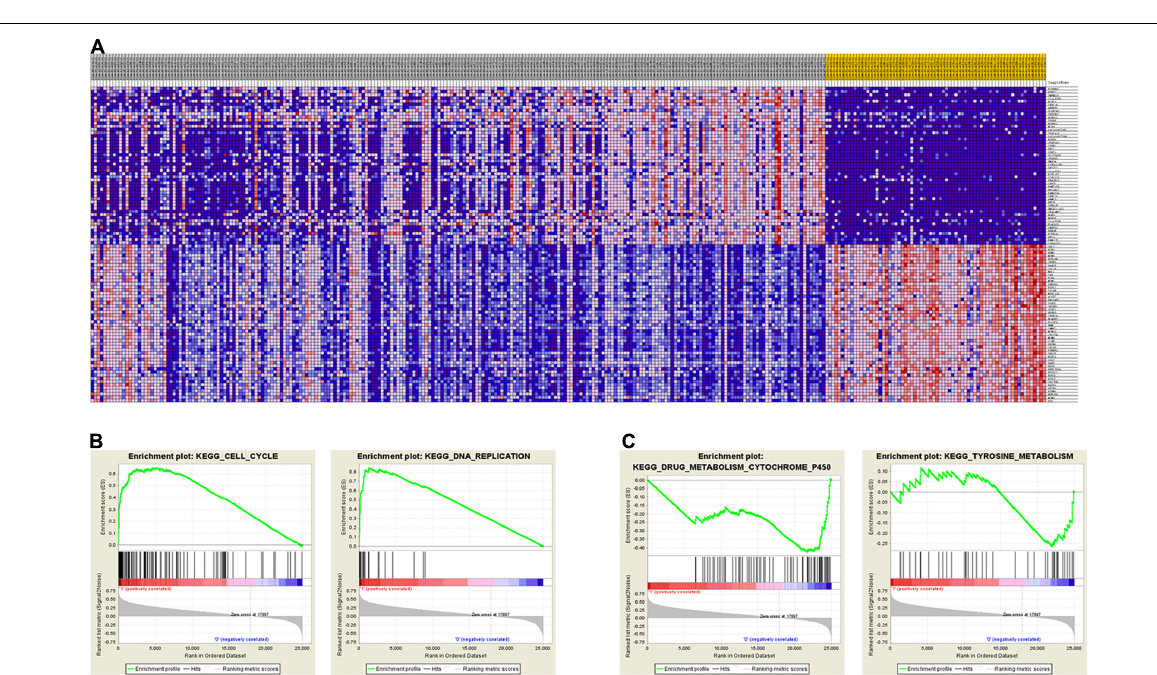
Frontiers in Genetics |